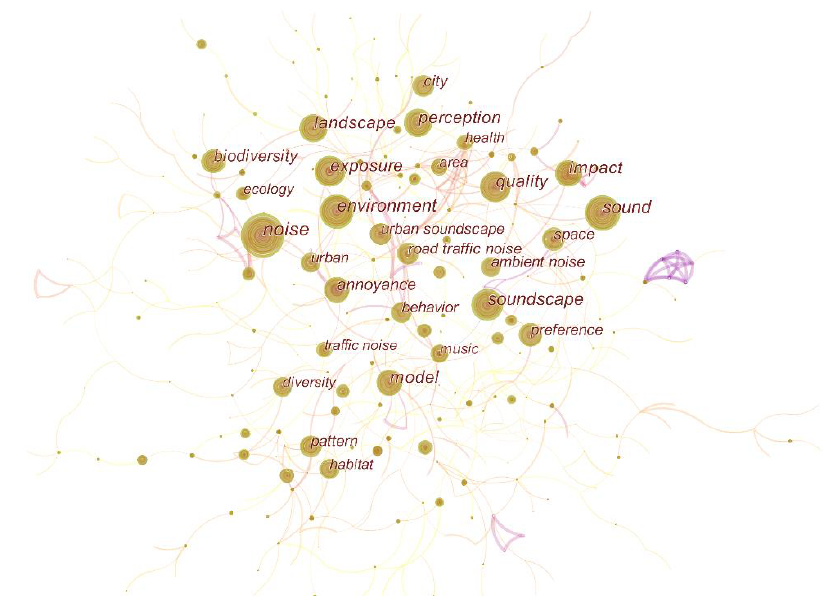
Figure 7. A network map showing keyword co-occurrence in soundscape research.